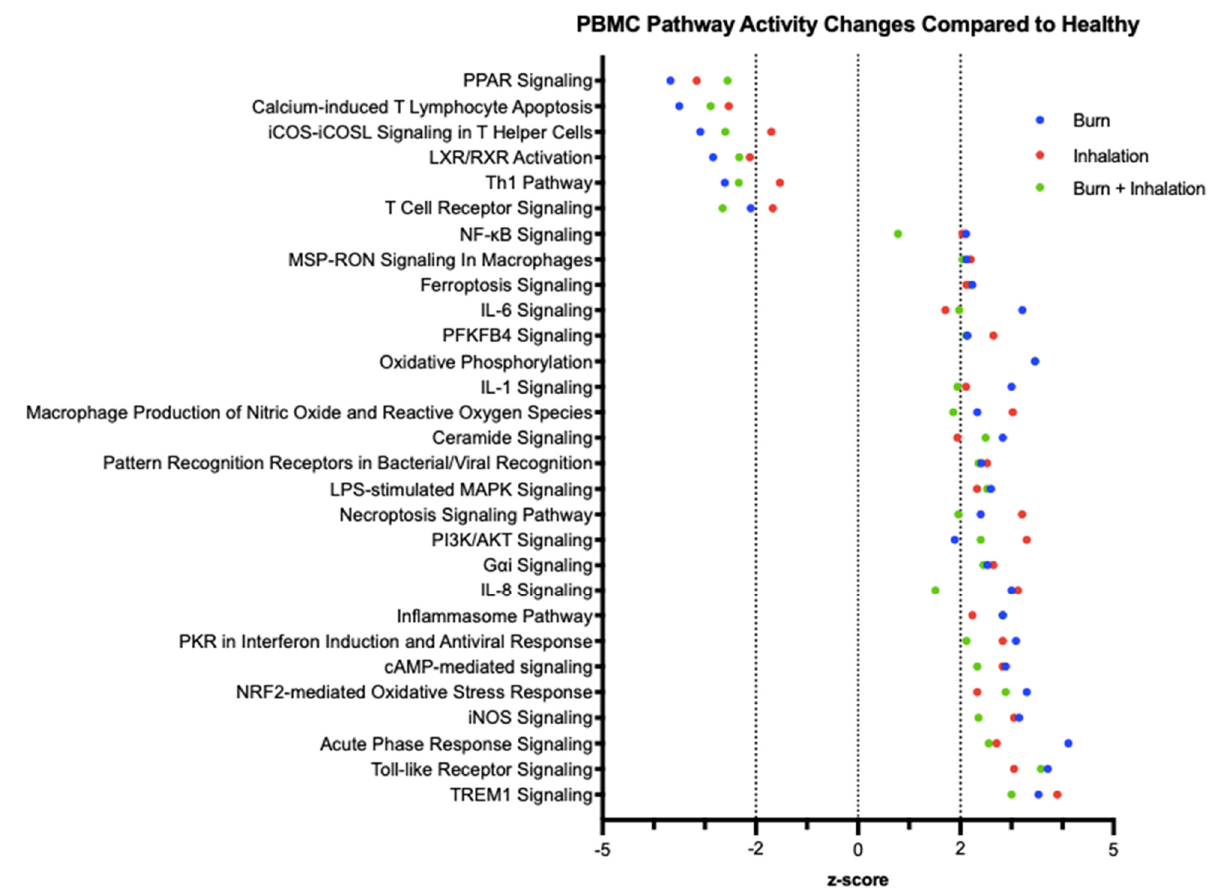
Figure 6. Burn, inhalation, and BI injuries induce significant alterations in peripheral immunometabolic canonical immune and metabolic signaling pathways compared to healthy controls. mRNA was isolated from PBMC, which was isolated from burn patients or healthy controls, and gene expression was evaluated using nanostring barcoding (nCounter Human Immune Profiling PanCancer CodeSet; 770 genes, and the Human Metabolic Gene CodeSet; 768 genes). Ingenuity pathway analysis (IPA) was employed to detect significant ( p < 0.05) changes in canonical immune and metabolic pathways and quantify